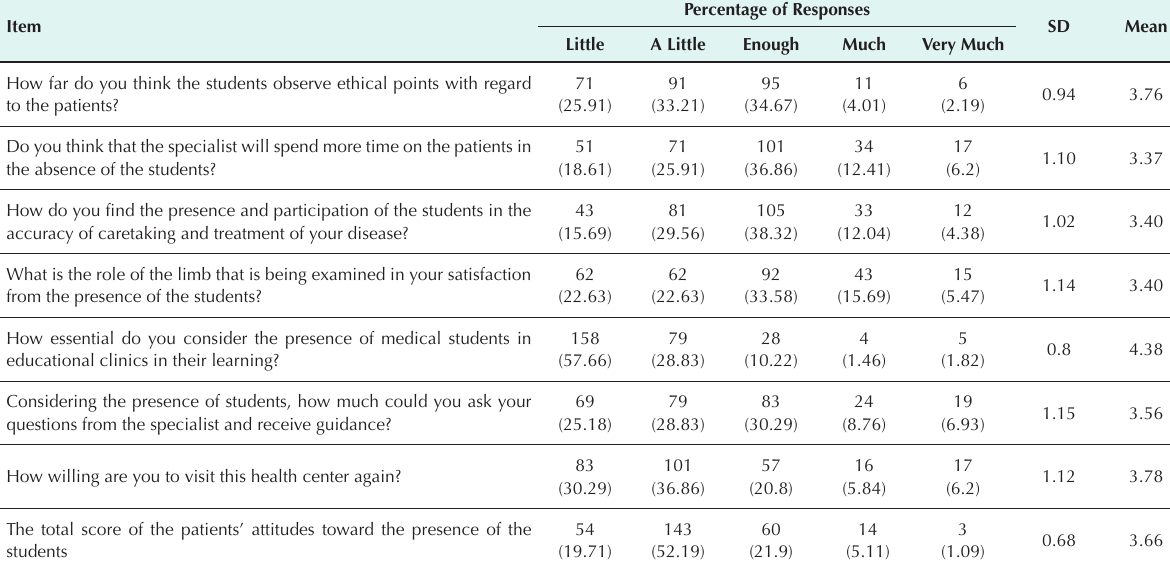
Table 3. Mean and SD of the Items Related to the Patients’ Attitudes Toward the Presence of the Students Item